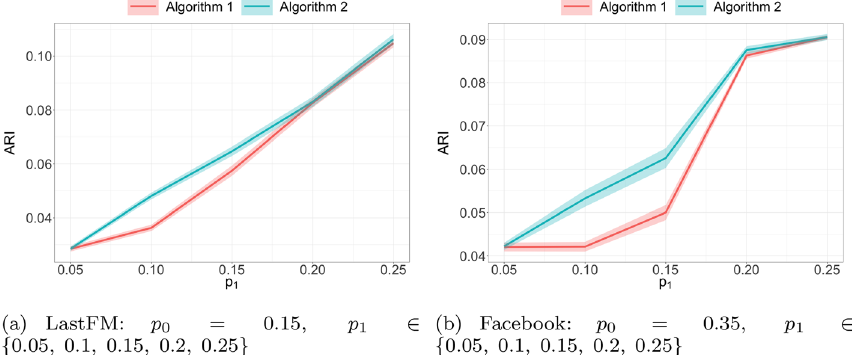
Fig. 8 Algorithms’ comparative performance on social network data via ARI with different initial sampling parameter p 0 and dynamic network sampling parameter p